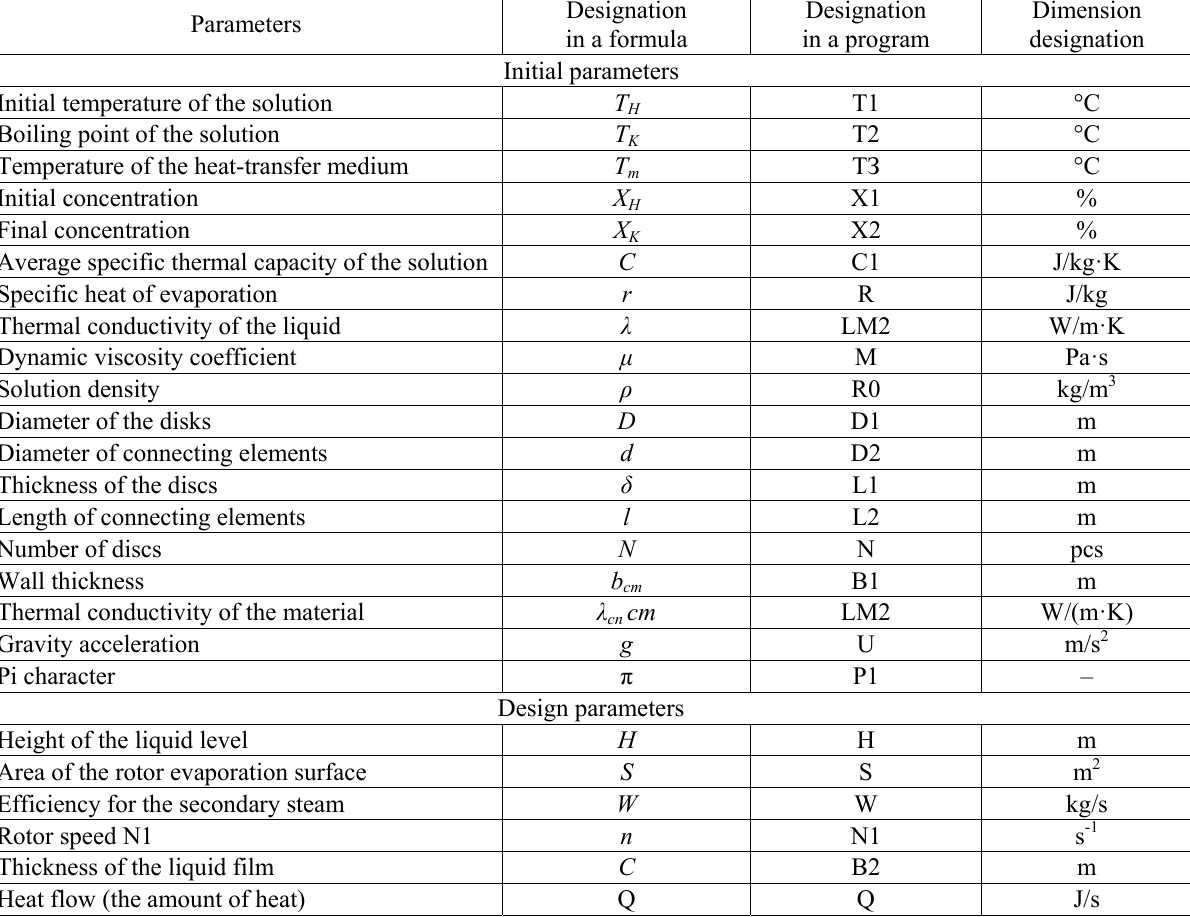
Table 1. Initial and calculated parameters and their